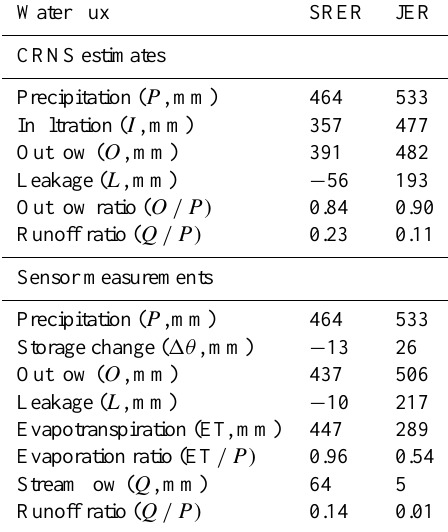
Table 5. Total water flux estimates from daily CRNS soil water bal- ance method ( f CRNS ) and daily sensor measurements during study period at the SRER and JER sites. P is from rain gauge measure- ments in both cases. L in CRNS is computed as O – ET where ET is from EC method, while L in sensor estimates is calculated from solving the water